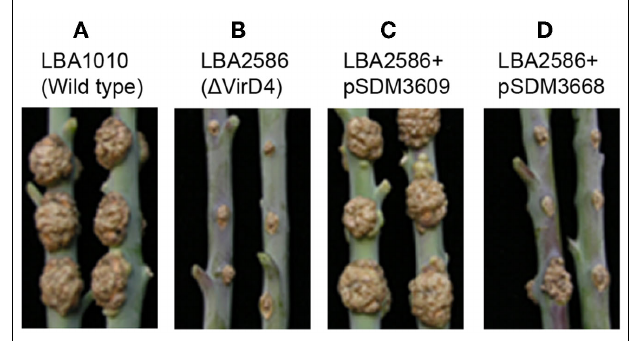
FIGURE 3 | Determination of virD4 -dependent virulence in tumor assay in N. glauca. Effects of virD4 deletion and/or replacement on A. tumefaciens virulence in N. glauca in a tumor assay . Tumor assay on N. glauca with A. tumefaciens strain (A) LBA1010 (wild-type), (B) LBA2586 (LBA1010 Δ VirD4), (C) LBA2586 + pSDM3609 ( A. tumefaciens wild-type VirD4), and (D) LBA2586 + pSDM3668 ( E. chaffeensis